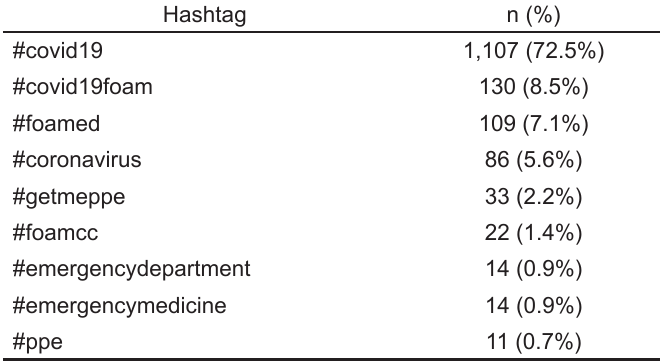
Table 2. Most frequent hashtags used in full sample of tweets (N = 1,315).